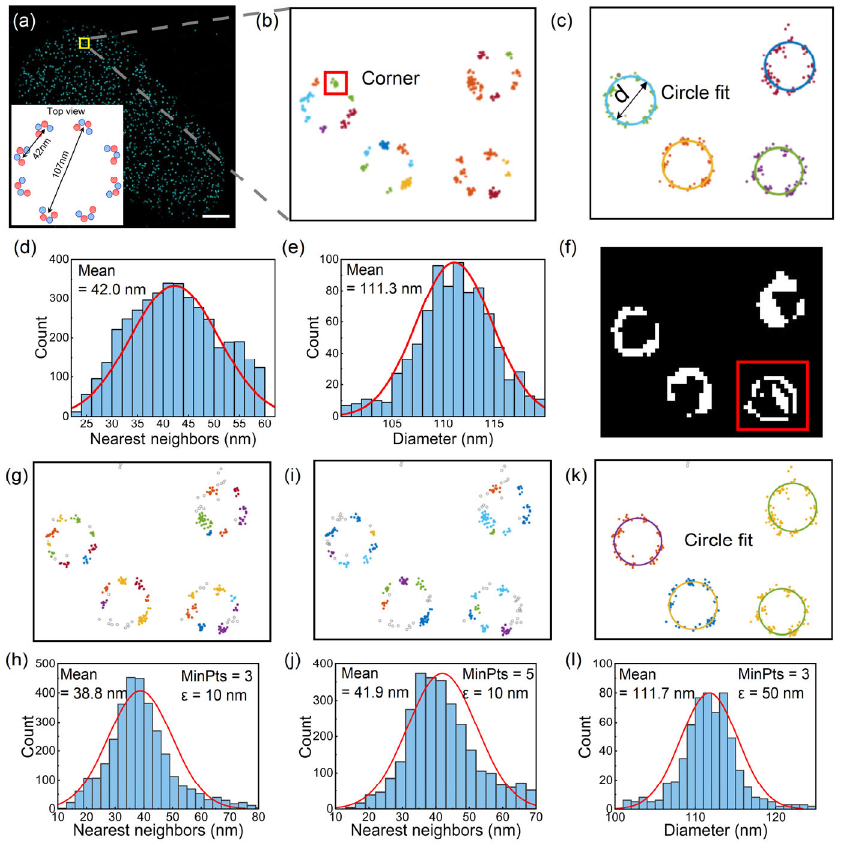
Figure 7. Validating the clustering performance of FACAM, Clusters, and DBSCAN on nuclear pore complexes. ( a ) A super-resolution image and a schematic top view (bottom left) of Nup96 structures. Scale bar: 1 µm. ( b – e ) The clustering result of FACAM. ( b ) The clustering results of Nup96 in the enlarged region in ( a ), using FACAM and adaptive segmentation threshold. ( c ) The clustering results of Nup96 in the enlarged region in ( a ), using FACAM and artificial segmentation threshold. ( d ) The distribution of nearest neighbors between corners. ( e ) The diameter distribution of Nup96. ( f ) The clustering results of Nup96 in the enlarged region in ( a ), using ClusterViSu. The red box shows the artifacts appeared inside the Nup96 structures. ( g – l ) The clustering result of DBSCAN. ( g , h ) The clustering results of Nup96 in the enlarged region in ( a ) and the distribution of nearest neighbors between corners, using DBSCAN (MinPts = 3, ε = 10 nm). ( i , j ) The clustering results of Nup96 in the enlarged region in ( a ) and the distribution of nearest neighbors between corners, using DBSCAN (MinPts = 5, ε = 10 nm). ( k , l ) The clustering results of Nup96 in the enlarged region in ( a ) and the diameter distribution of Nup96, using DBSCAN (MinPts = 3, ε = 50